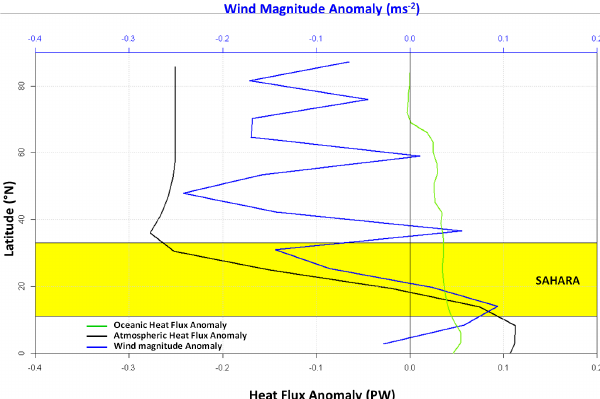
Figure 4. The (i) mean annual oceanic heat flux anomaly (PW) (green line), (ii) mean annual atmospheric heat flux anomaly (PW) (black line) and (iii) mean annual wind magnitude anomaly (ms − 2 ) (blue line) over the North Atlantic (defined as 60 ◦ W–15 ◦ E) (9k0kEQ_OG–9k9kEQ_OG). The latitudinal extent of the Sahara is highlighted for